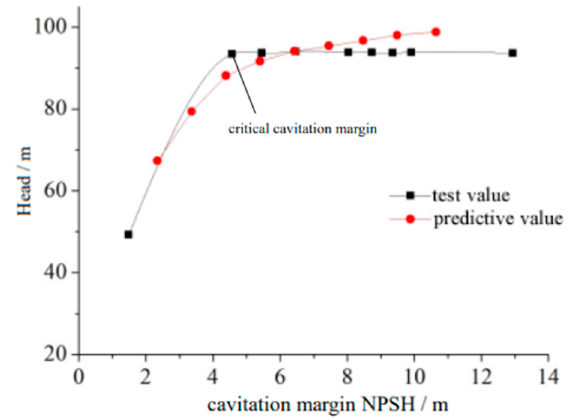
Figure 10. Cavitation margin and head curve of the vortex